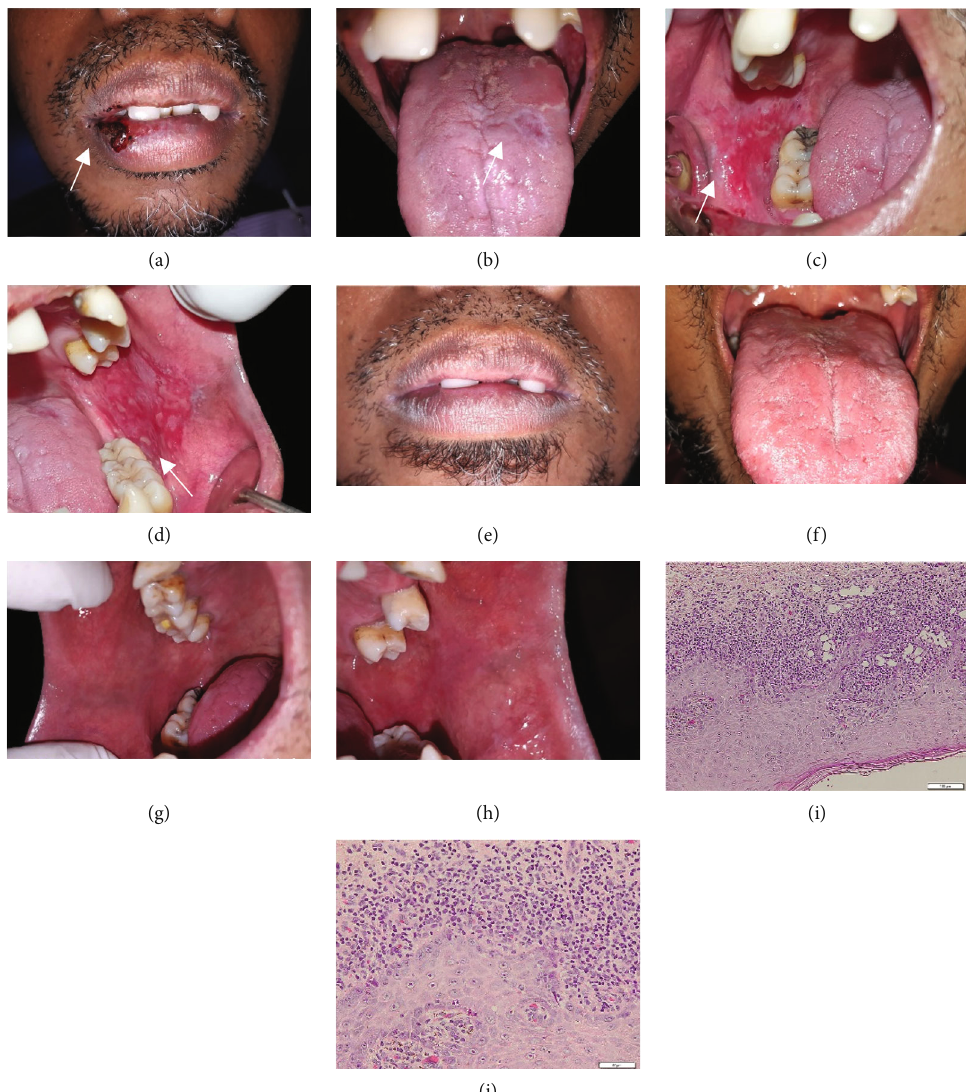
Figure 1: The clinical features of OLP in a 42-year-old man; (a) hemorrhagic crust, erosive surrounded by radiating white striae (Wickham striae) on the lower lip; (b). Erosive lesion surrounded by Wickham striae on the left dorsum of the tongue; (c) and (d). Erosive and ulcerative lesions on the right and left buccal mucosa; (e) – (h) Lesions on the lips, dorsum of the tongue, and the buccal mucosa completely healed after two months of treatment; (i) and (j) Histopathological features of the lesion with 100x and 400x magni fi